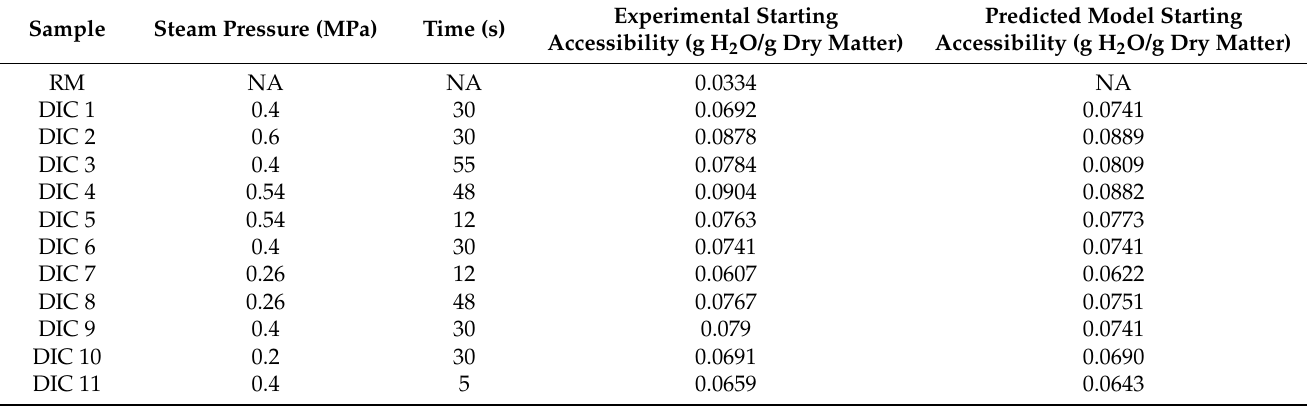
Table 5. Experimental data and predicted model results of the starting accessibility of mangoes.